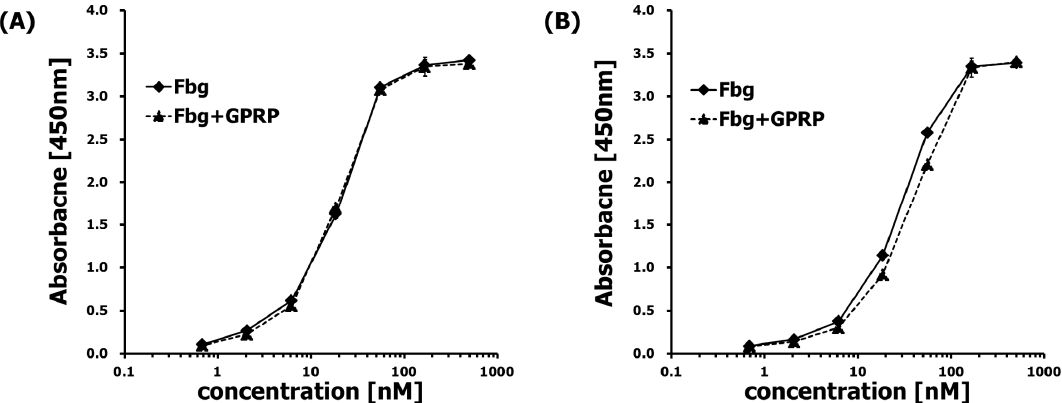
Figure 3. A β 42 binds to Fbg and Fbg-GPRP peptide (1:50 molar ratio). ( A ) detecting by polyclonal rabbit anti-Fbg and ( B ) monoclonal anti-Fbg 85D4.